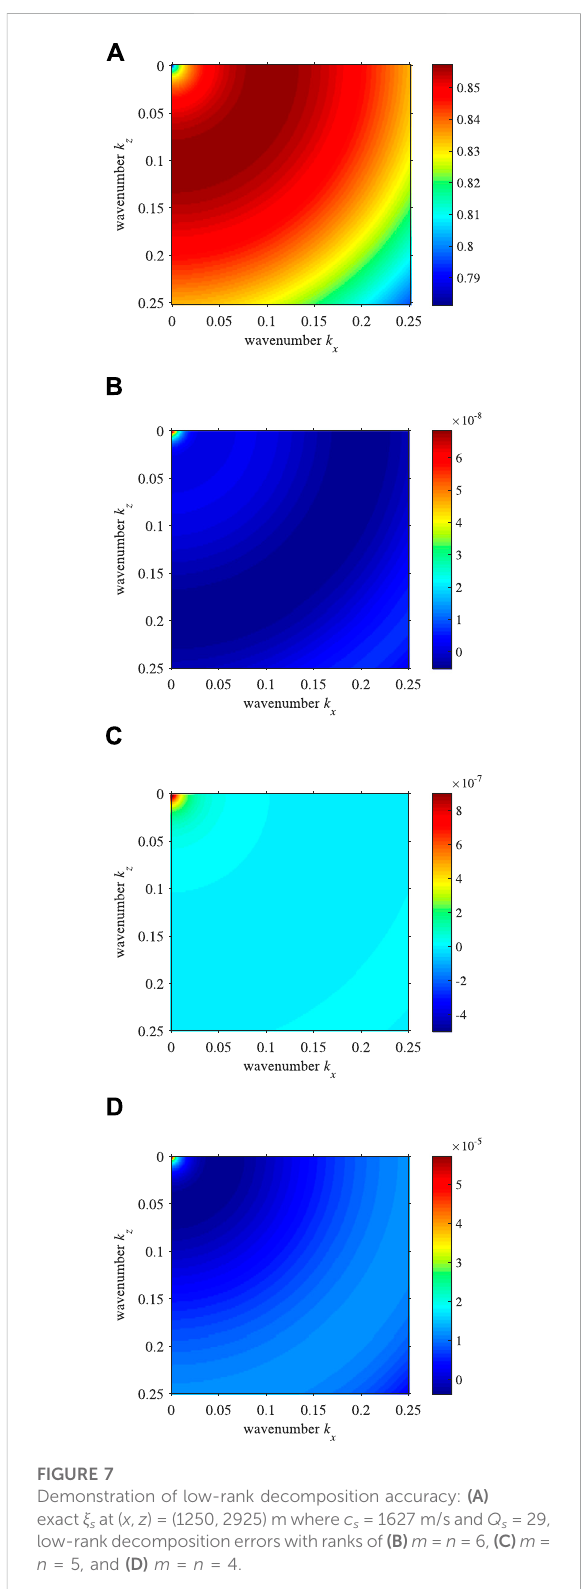
FIGURE 7 Demonstration of low-rank decomposition accuracy: (A) exact ξ s at( x , z )=(1250,2925) m where c s = 1627 m/sand Q s = 29, low-rankdecompositionerrorswithranksof (B) m = n =6, (C) m = n = 5, and (D) m = n =